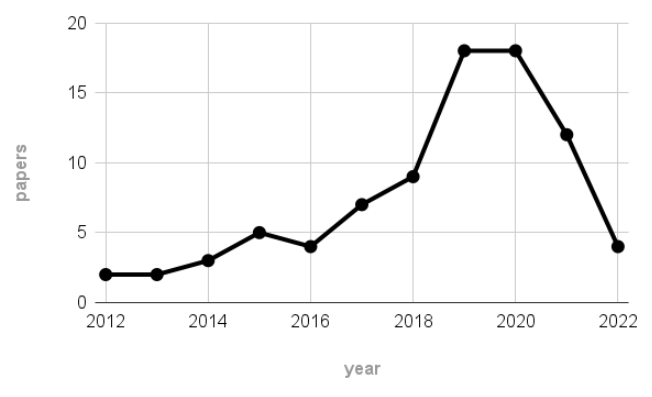
Figure 2. Number of papers remaining after the scraping process per each considered year (1 January 2012–22 June 2022).